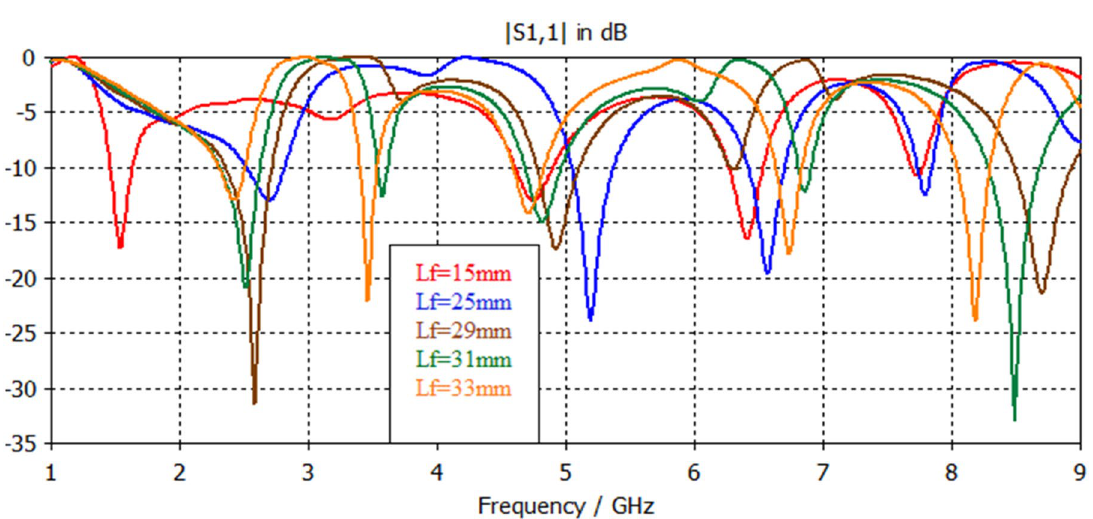
Figure 18. S11 responses of the antenna structure depicted in Fig. 2 with a feedline length as a